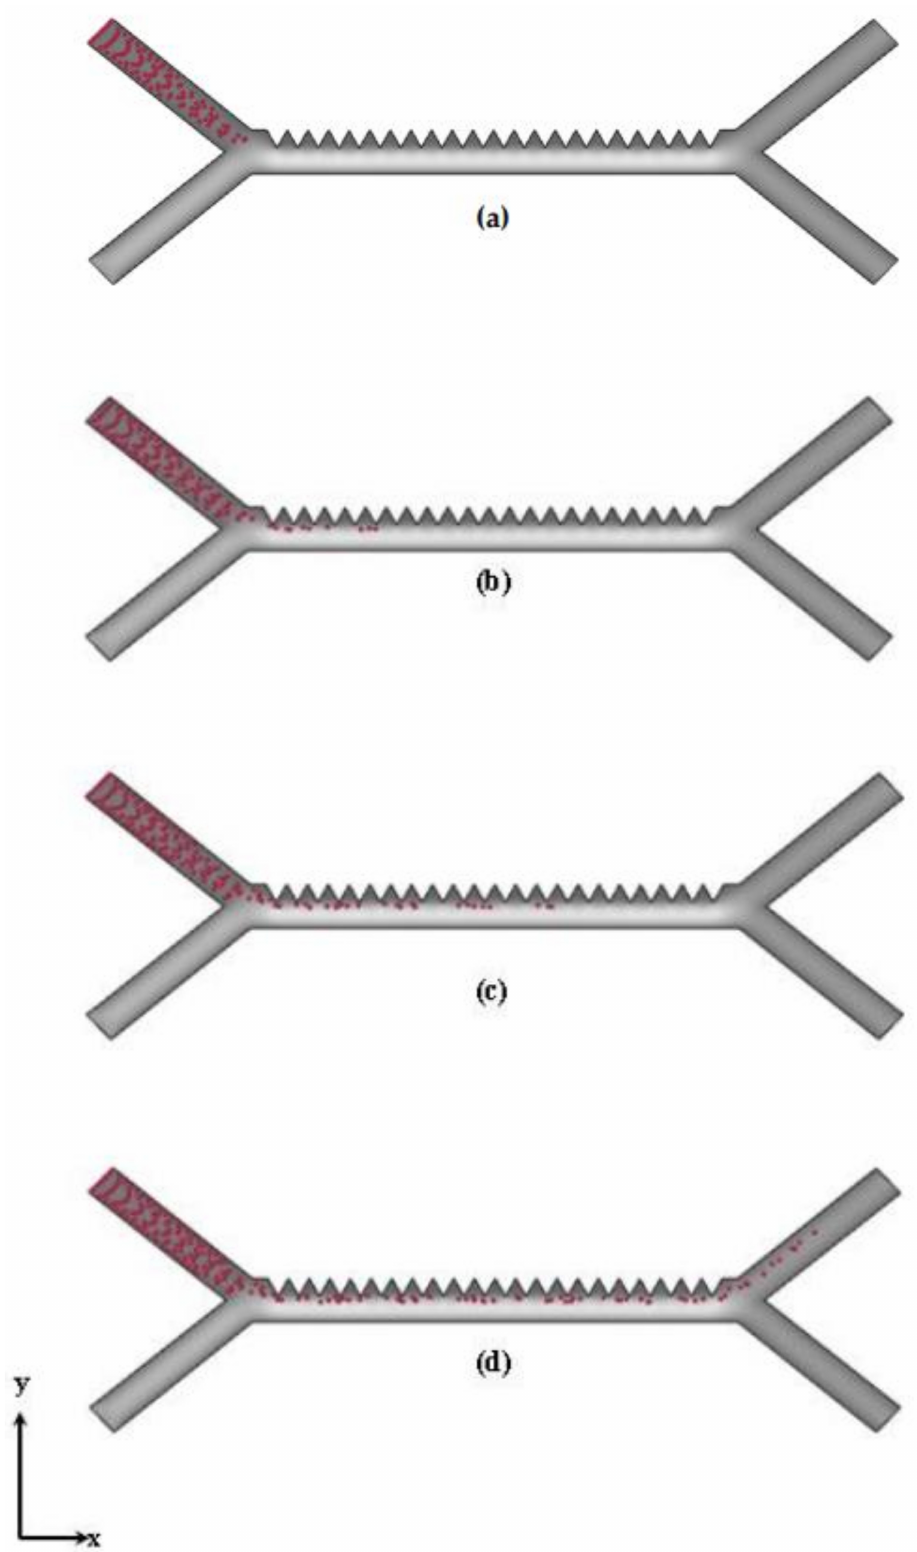
Figure 15. RBC and platelet continuous flow tracking with the electrodes turned off at times: ( a ) t = 1 s, ( b ) t = 1.25 s, ( c ) t = 1.5 s, ( d ), t = 2 s. As mentioned previously, for sake of visualization, the relative size of the RBCs has been divided by